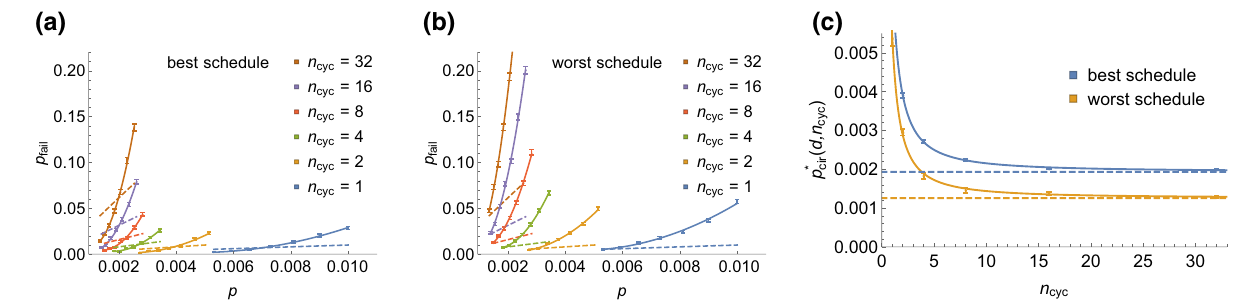
FIG. 36. Performance comparison of (a) the best ranked, and (b) the worst ranked length-7 CNOT schedules, namely { 4, 1, 2, 3, 6, 5; 3, 2, 5, 6, 7, 4 } and { 4, 1, 2, 7, 6, 3; 1, 6, 7, 4, 5, 2 } . We numerically estimate the failure probability of n circuit noise of strength p for d = 13 given a perfect initial state and final QEC cycle. We fit this data with quadratic functions (solid lines), and also show the physical qubit error probability p phy ( n cyc ) (dashed curves). We estimate the pseudothreshold p ∗ which we plot in subfigure (c) by identifying the intersection of the solid and dashed curves for a given d , p , and n cyc . We see that the long-time pseudothreshold for the good circuit is 0.193 ( 2 ) % (blue, dashed), considerably larger than that of 0.126 ( 3 ) % for the bad circuit (yellow, dashed).